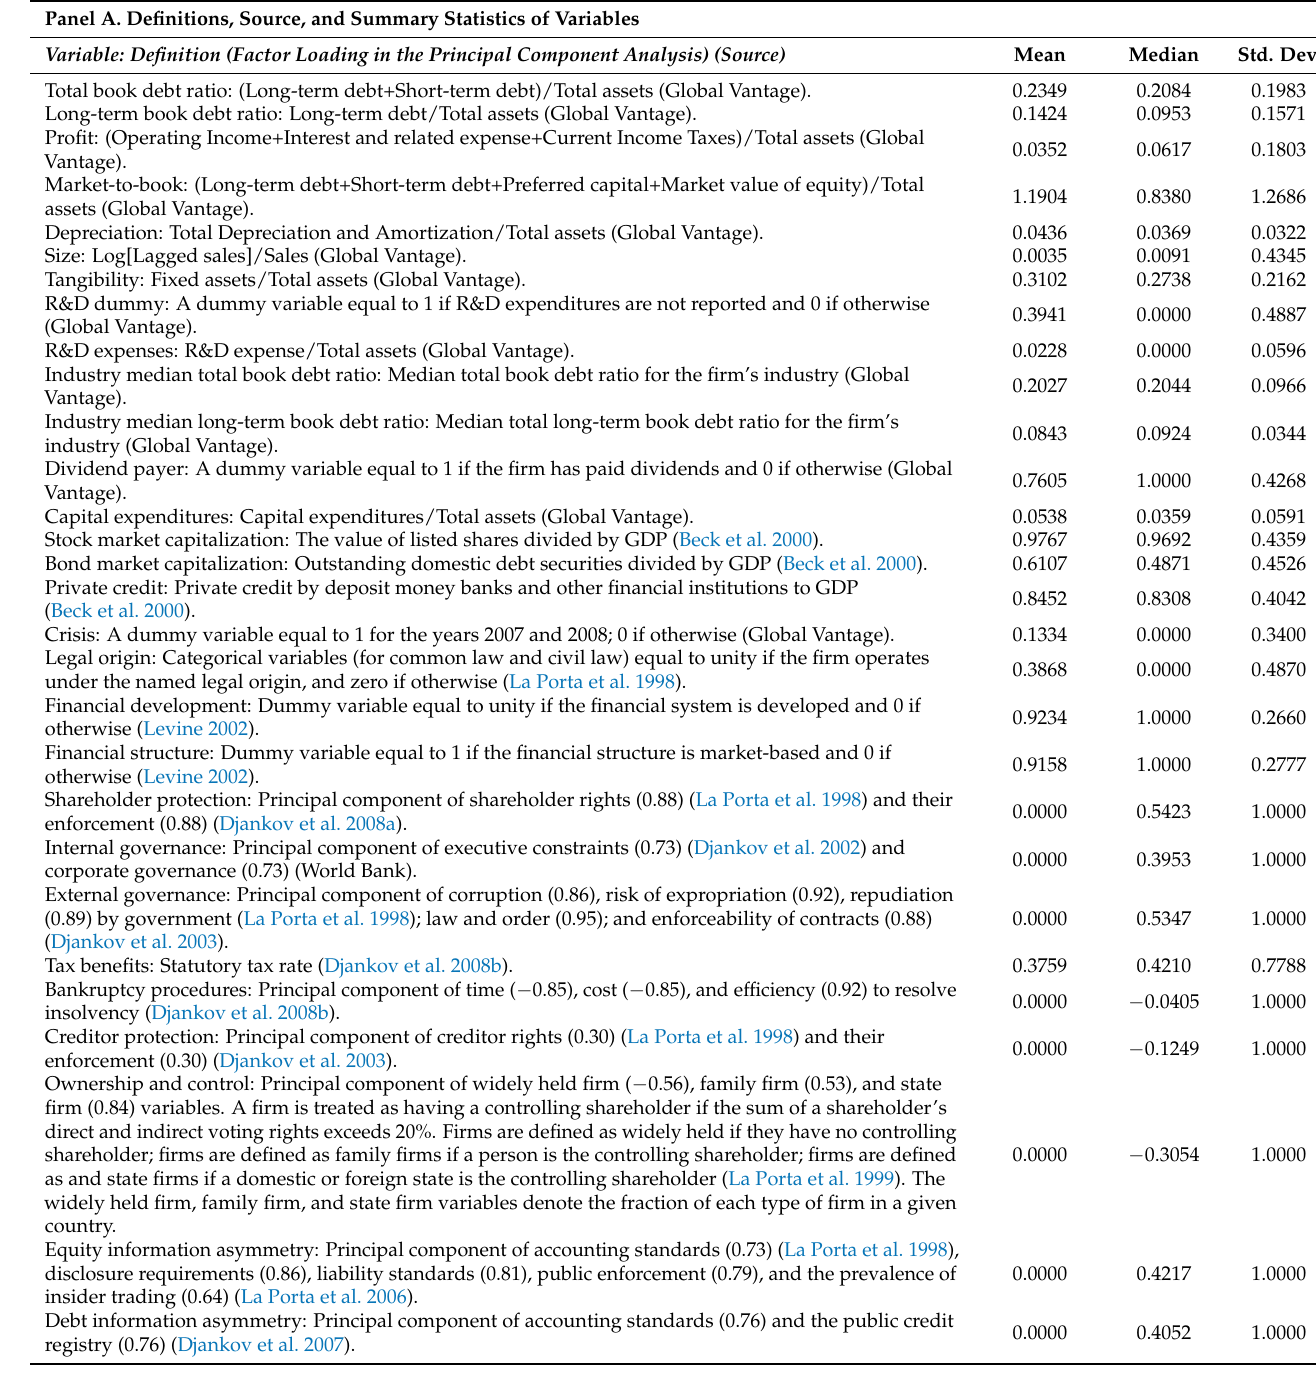
Table 1. Data description, summary statistics, and